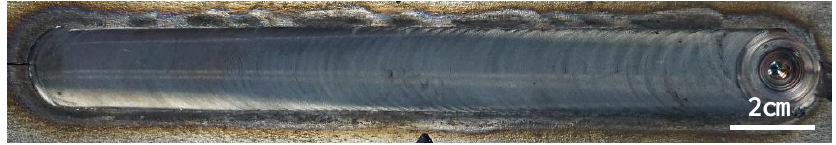
Figure 1. Appearance of the friction stir welding (FSW) joint.